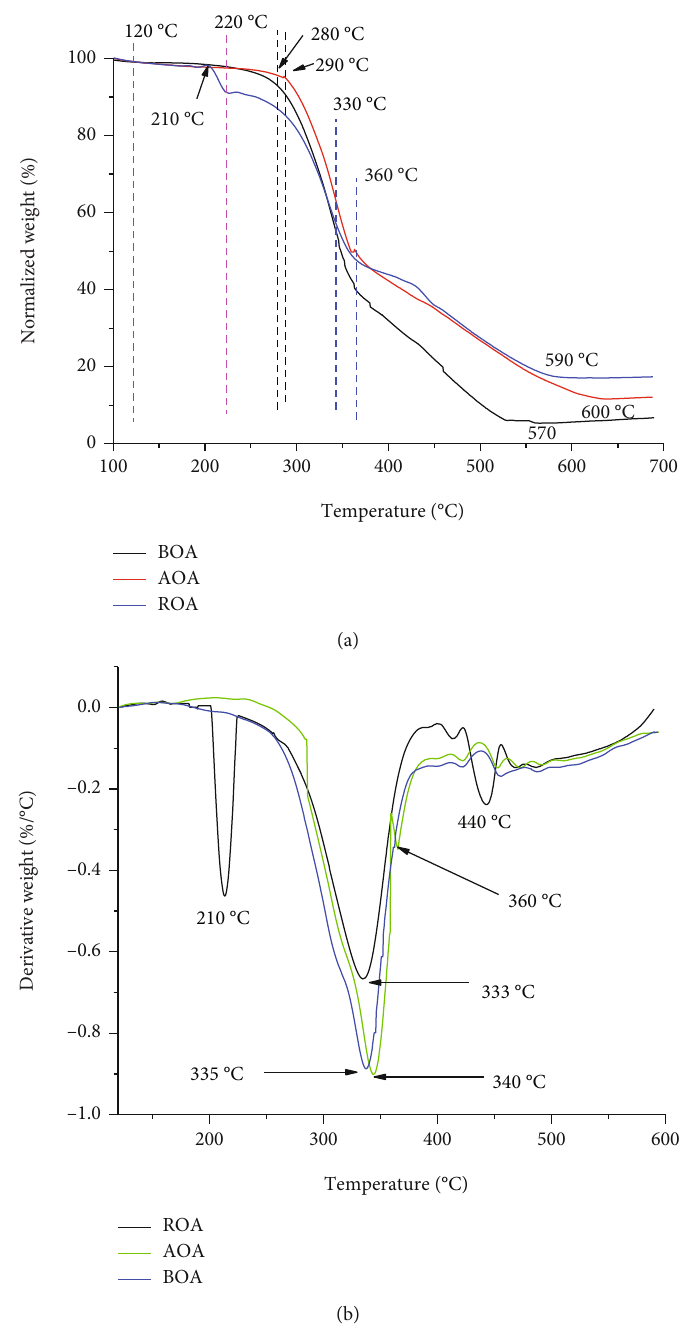
Figure 9: Normalized TGA curve of ROA, AOA, and BOA samples (a) and their DTG peaks